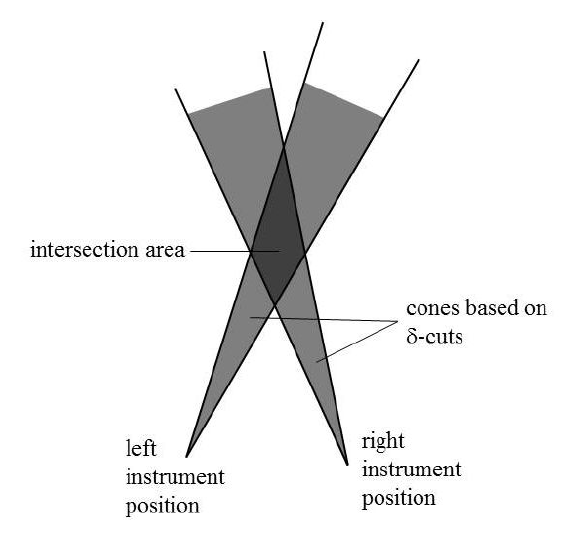
Figure 8. Concept of cone boundary intersection method; the position of the target is somewhere in the intersection area